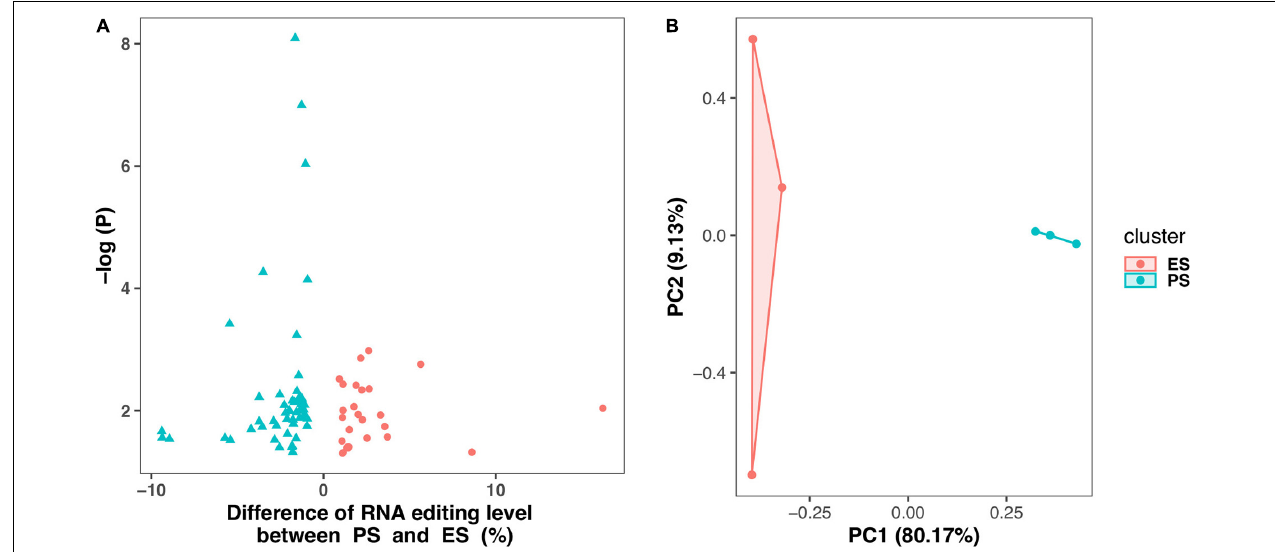
FIGURE 7 | Differential G-to-A RNA editing events between PS and ES. (A) 63 events showed differential editing levels between CSDS and controls, including 42 and 21 are upregulated in PS and ES, respectively. (B) Principle component analysis of these Differential G-to-A RNA editing between PS and